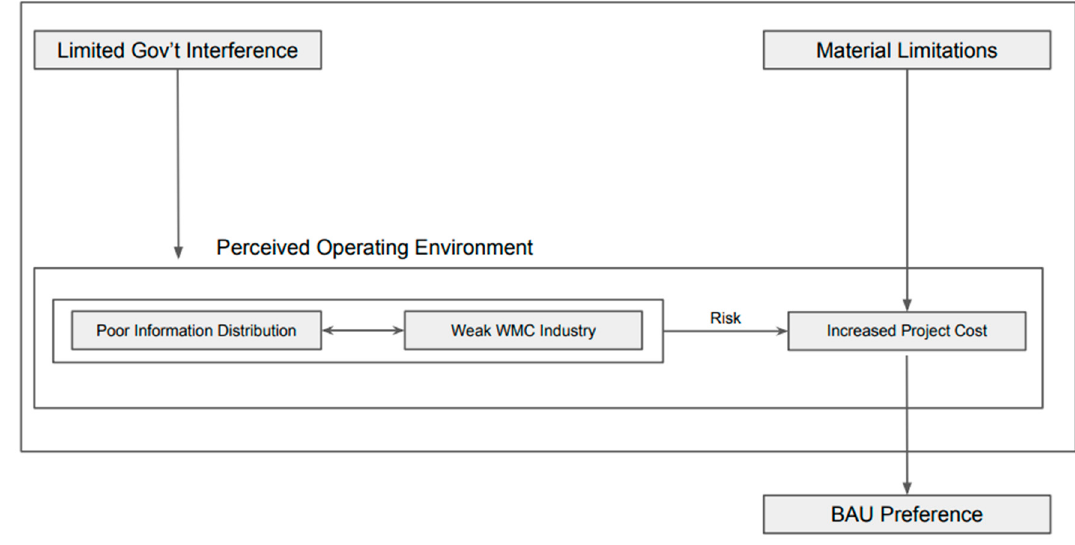
Figure 2. Depiction of relationships between perceived hindrances discussed by civil servants.